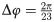
Class probability graph.The class probability graph displays label probability scores of 144 samples that are based on 6 source images. The samples were created by rotation of the source images about Δφ=2π23. Rotations of the samples are shown at the first line (in degrees). Each class is associated with one colour. The class of the source image is highlighted using the appropriate colour. The assigned probability scores of the sample are displayed using the coloured bar.